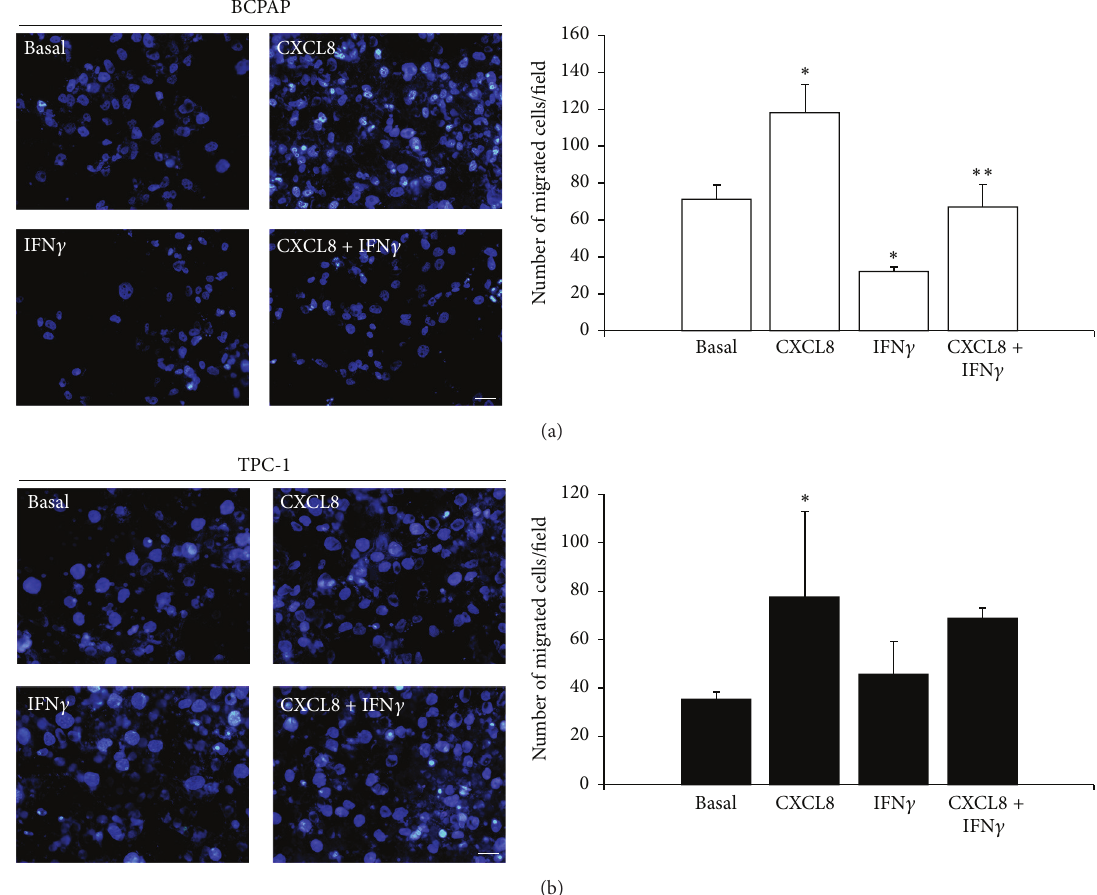
Figure 4: Representative images and the respective histograms of (a) BCPAP and (b) TPC-1 after 16 hours of migration within the transwell migration chamber system in different conditions. Nuclei were counterstained with Hoechst 33258 in blue (images were acquired by an Olympus BX51, magnification 20x, scale bar = 50 𝜇 m). Bar graphs show the corresponding analysis of migrated cells on the lower side of the transwell filter. BCPAP: ANOVA F = 58.71; 𝑝 < 0.0001 ; post hoc analysis by Bonferroni: 𝑝 < 0.001 CXCL8 versus basal; 𝑝 < 0.05 IFN 𝛾 versus basal; 𝑝 < 0.005 IFN 𝛾 + CXCL8 versus IFN 𝛾 . TPC-1: ANOVA F = 8.85 𝑝 < 0.05 ; post hoc analysis by Bonferroni: 𝑝 < 0.05 CXCL8 versus basal; NS IFN 𝛾 versus basal; NS IFN 𝛾 + CXCL8 versus IFN 𝛾 . ∗ 𝑝 < 0.05 versus basal; ∗∗ 𝑝 < 0.05 versus CXCL8 + IFN 𝛾